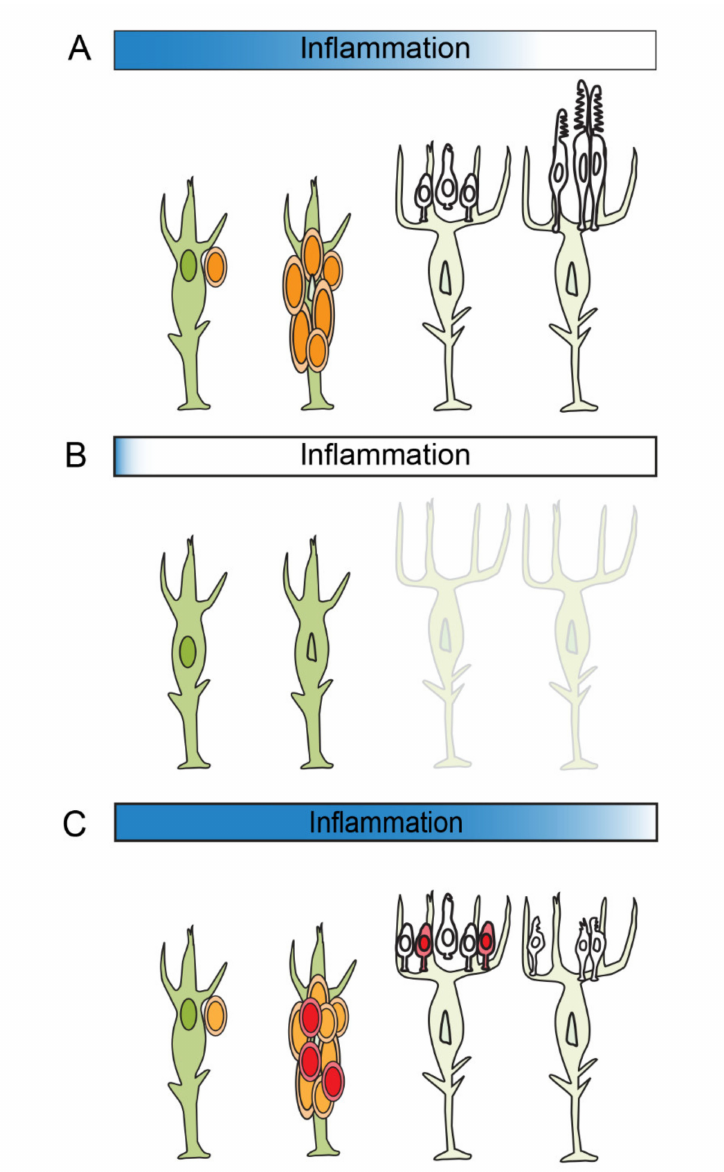
Figure 2. Model of how inflammation regulates photoreceptor regeneration in zebrafish. ( A ) Follow- ing cell death, acute inflammation stimulates reprogramming and cell division among Müller glia and proliferation of Müller glia-derive progenitors. As inflammation resolves, Müller glia-derived progen- itors exit the cell cycle and differentiate into photoreceptors. ( B ) Suppression of acute inflammation results in the failure of Müller glia to proliferate. ( C ) If acute inflammation is prolonged, Müller glia-derived progenitors undergo extra rounds of cell division. If resolution of acute inflammation fails, this compromises the maturation and survival of